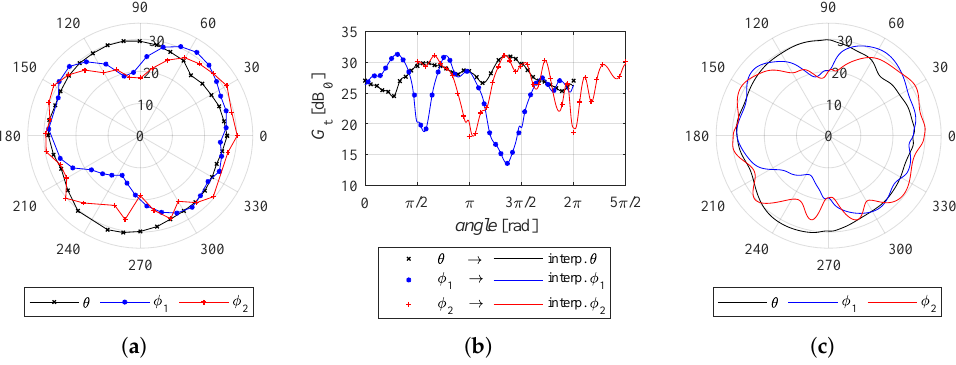
Figure 3. ( a ) Original experimental radiation pattern sections on the θ , φ 1 , and φ 2 planes; ( b ) ap- proximation procedure forcing identical values on intersections; and ( c ) radial projection of the approximated radiation pattern sections. These are used to reconstruct the 3D radiation pattern.